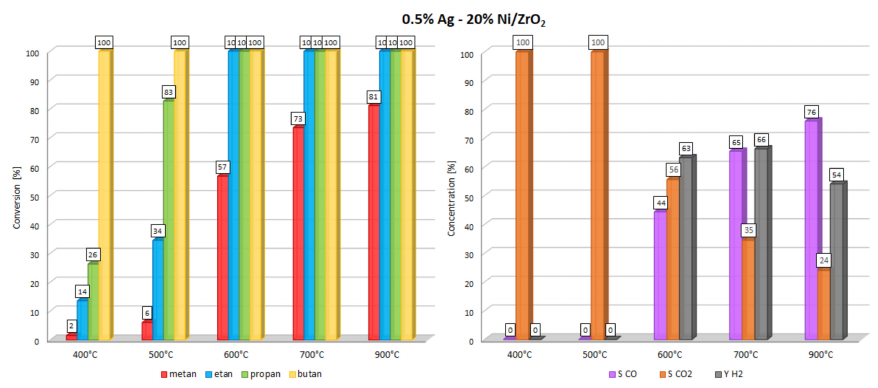
Figure 4. The activity results of the 0.5% Ag-20% Ni / ZrO 2 catalyst in OSR-LNG